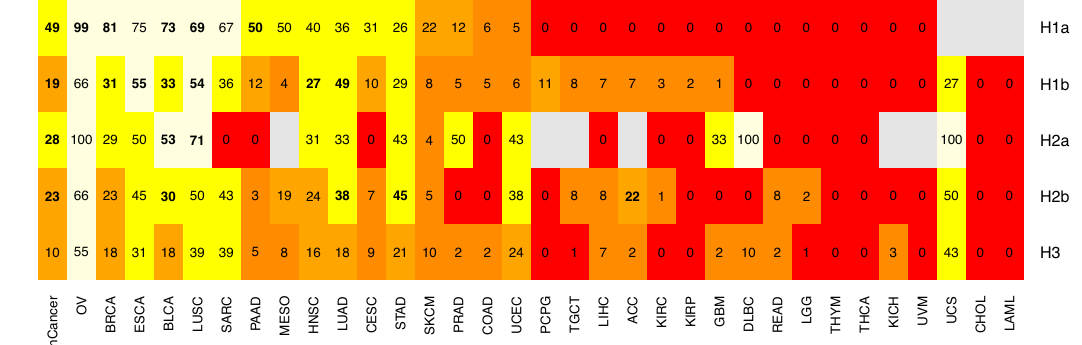
Fig. 1 Pan-cancer analysis of HRR gene mutations and genomic scar signatures (TCGA cohort). a Tumors with deleterious alterations in BRAC1/2 (H1a), in other HHR genes (H1b), VUS in BRCA1/2 (H2a) and in other HRR genes (H2b). b Distribution of the HRDsum score and percentage of cases classi fi ed as HRD-positive by HRDsum (cutpoint: 42) and by SBS3 (cutpoint: 0). HRDsum was calculated starting from genotyping data (SNP arrays). c Percentage of HRD-positive (HRDsum ≥ 42) tumors in the fi ve classes H1a-H3 (grey = no cases). Signi fi cant enrichments of HRD-positive tumors compared to H3 are shown in bold